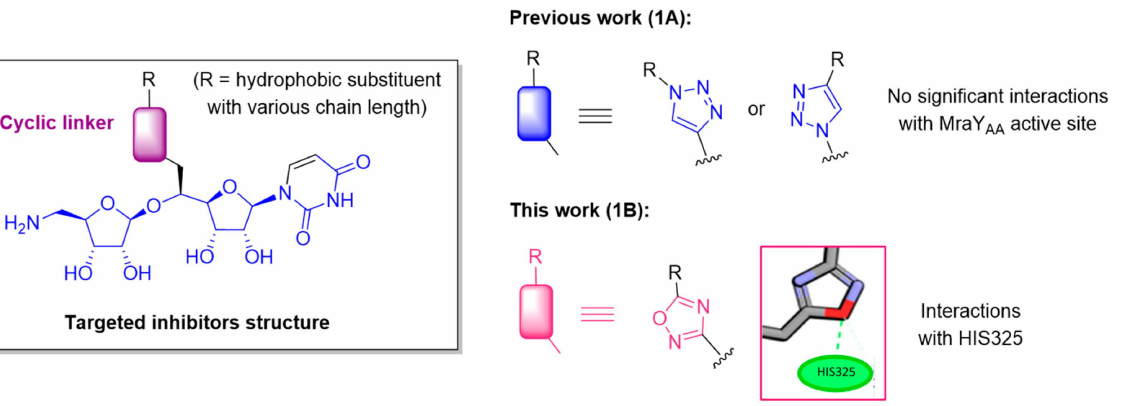
Figure 1. 1A. Structure of the aminoribosyl-uridine-containing MraY inhibitors previously syn- thetized. 1B. Structure of targeted new MraY